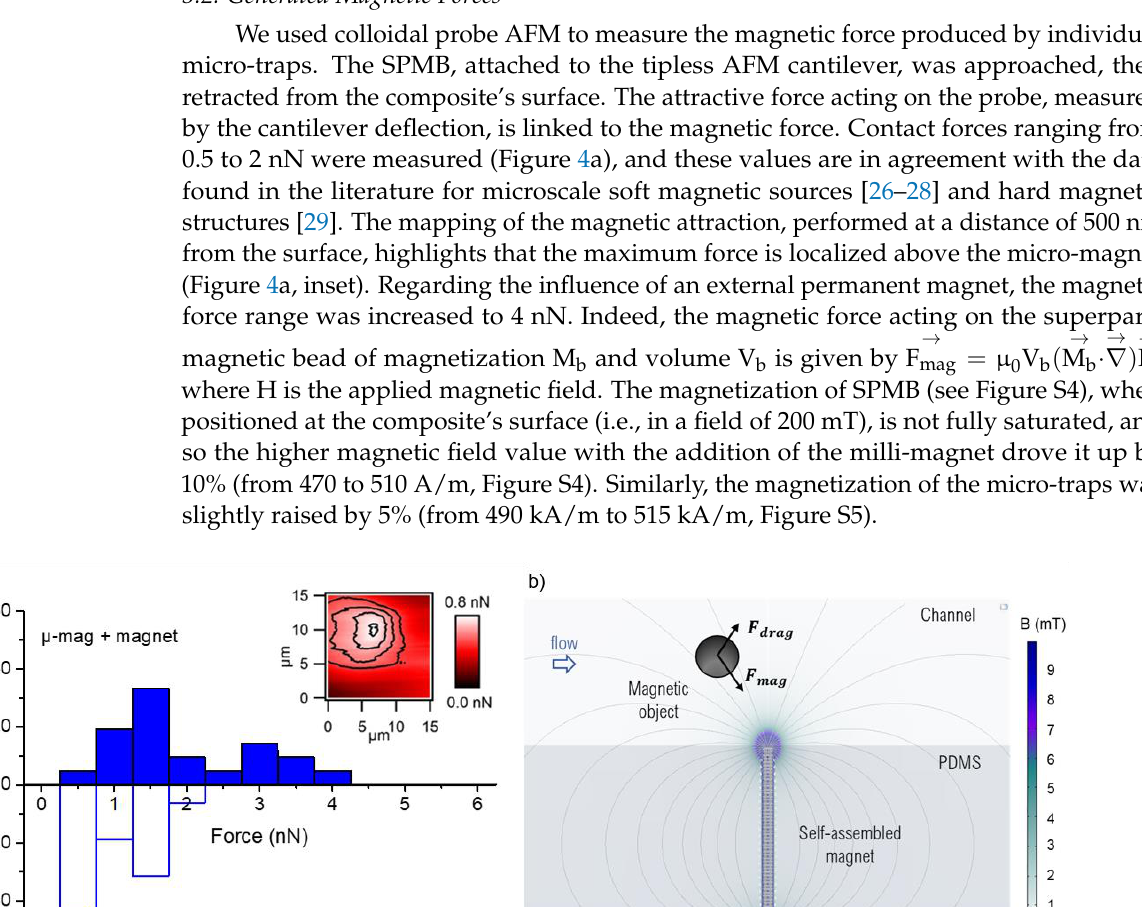
Figure 3. ( a ) Magnetization of the NdFeB@PDMS membrane, measured out-of-plane. The light grey curve is the first mag- netization curve with successive measurements of remanent magnetization. The thick red curve highlights the remanent magnetization at 1 T. The blue curve is the full magnetization loop. ( b ) COMSOL simulations of the magnetic field and magnetic field gradient (defined by Cm,z) generated by the micro-magnets (µ-mag) as a function of the distance from the composite surface, with or without an external magnet below the composite surface.